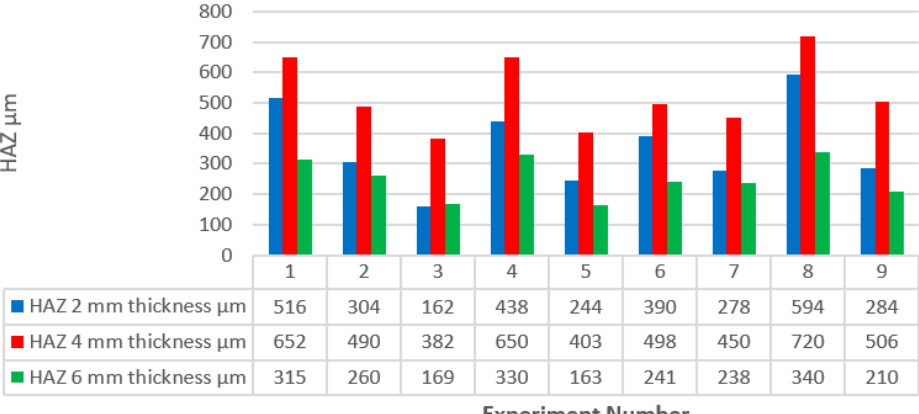
Figure 7. HAZ relative to experiment number and specimen thickness.